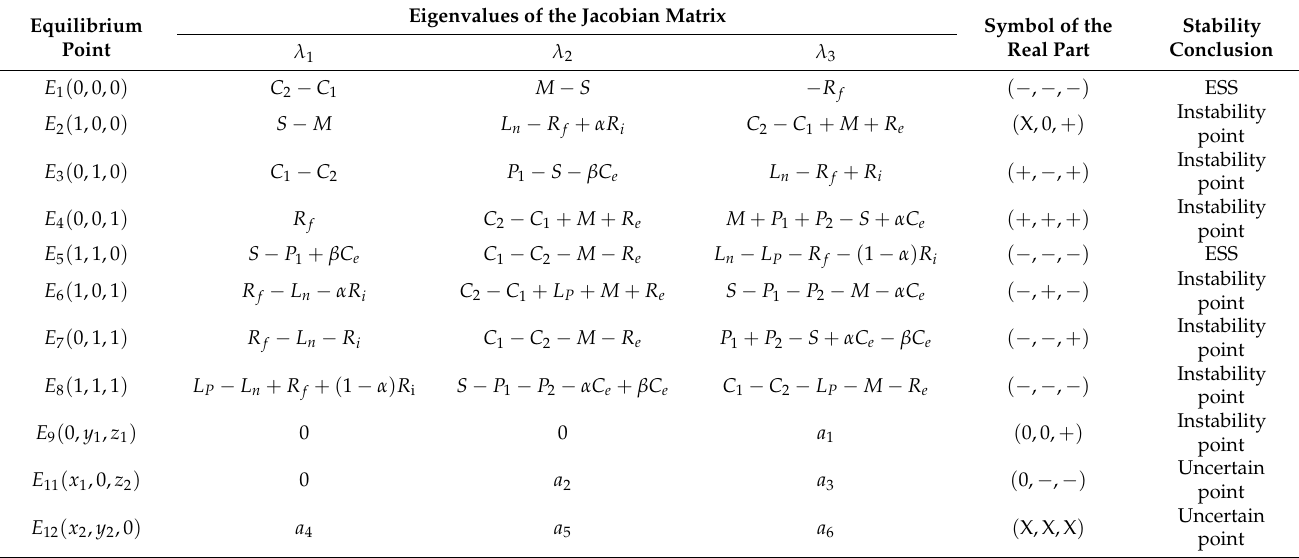
Table 3. The parameters matrix of benefits of the three-party game. Eigenvalues of the Jacobian Matrix Symbol of the